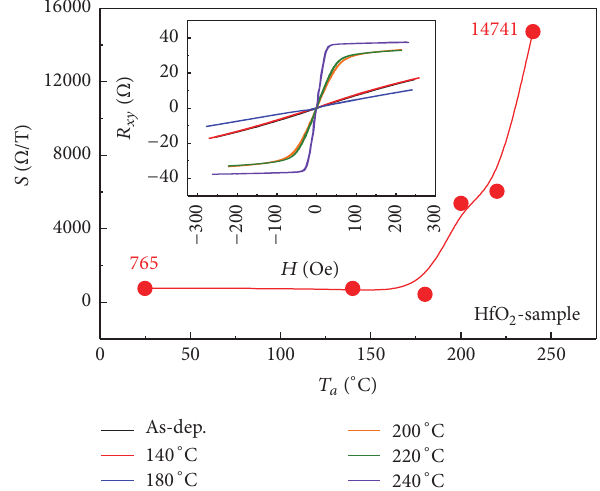
Figure 2: Annealing temperature dependence of the anomalous Hall sensitivity for the sample Ta(0.8)/Co 20 Fe 80 (0.8)/HfO 2 (0.8)/ Ta(1.0) (in nm). Inset: anomalous Hall loops of the sample in the as-deposited and different annealed